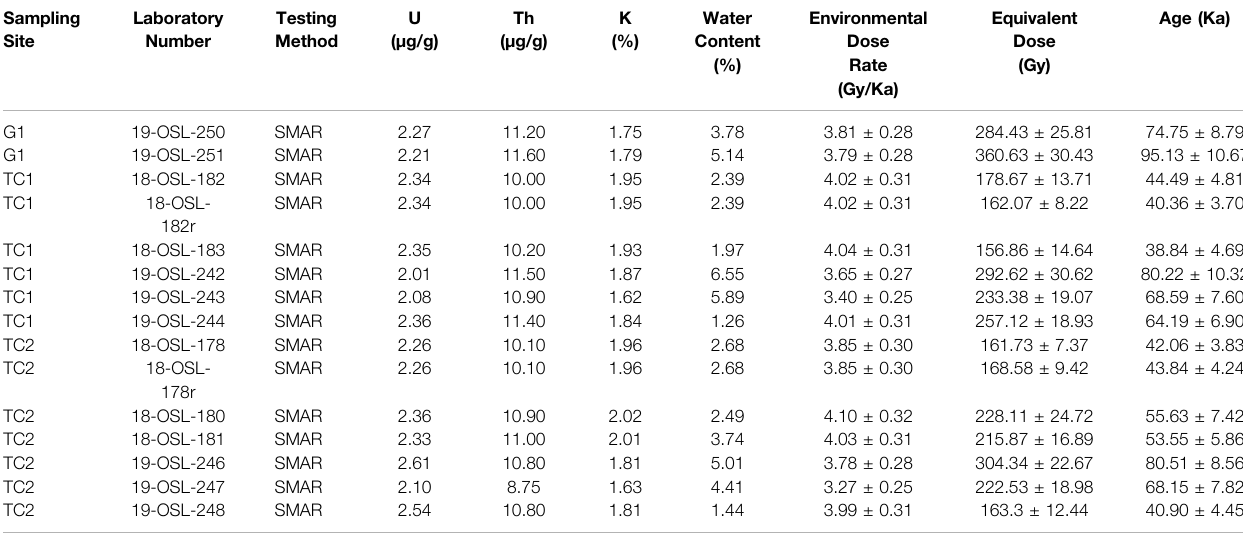
TABLE 1 | OSL dating results of the Kouma Fault. Sampling